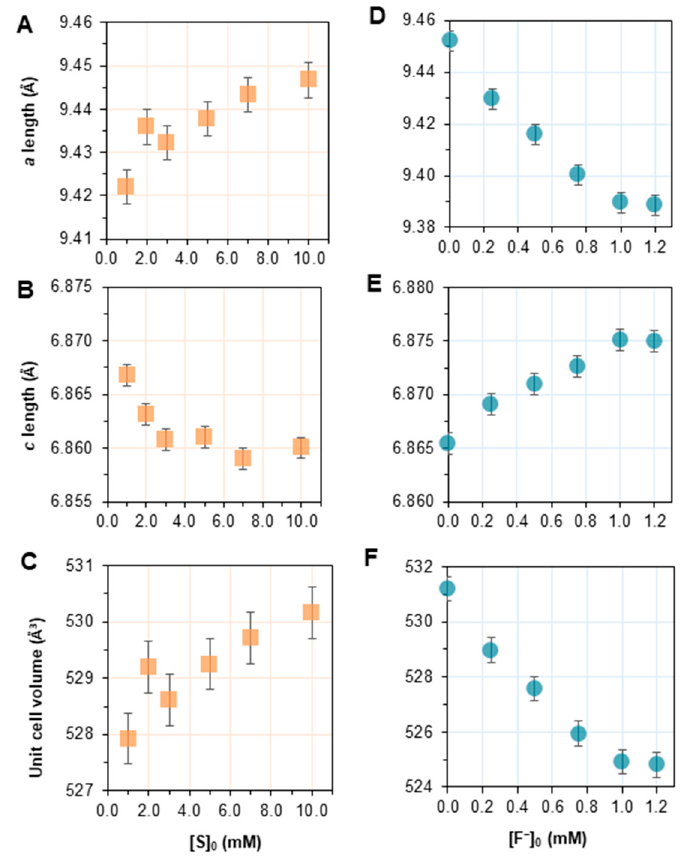
Figure 4. Comparative plots for unit cell dimensions of substituted HAP synthesized by homo- geneous enzymatic catalysis ( A – C ) with variable substrate concentrations (orange squares) or ( D – F ) with [S] 0 = 7.0 mM and variable fluoride concentrations (blue symbols). ( A , B , D , E ) Lengths of unit cell parameters were determined by refinement of X-ray powder diffraction data. ( C , F ) Unit cell volume was calculated from the lattice parameters based on the formula for a unit cell with hexagonal symmetry.